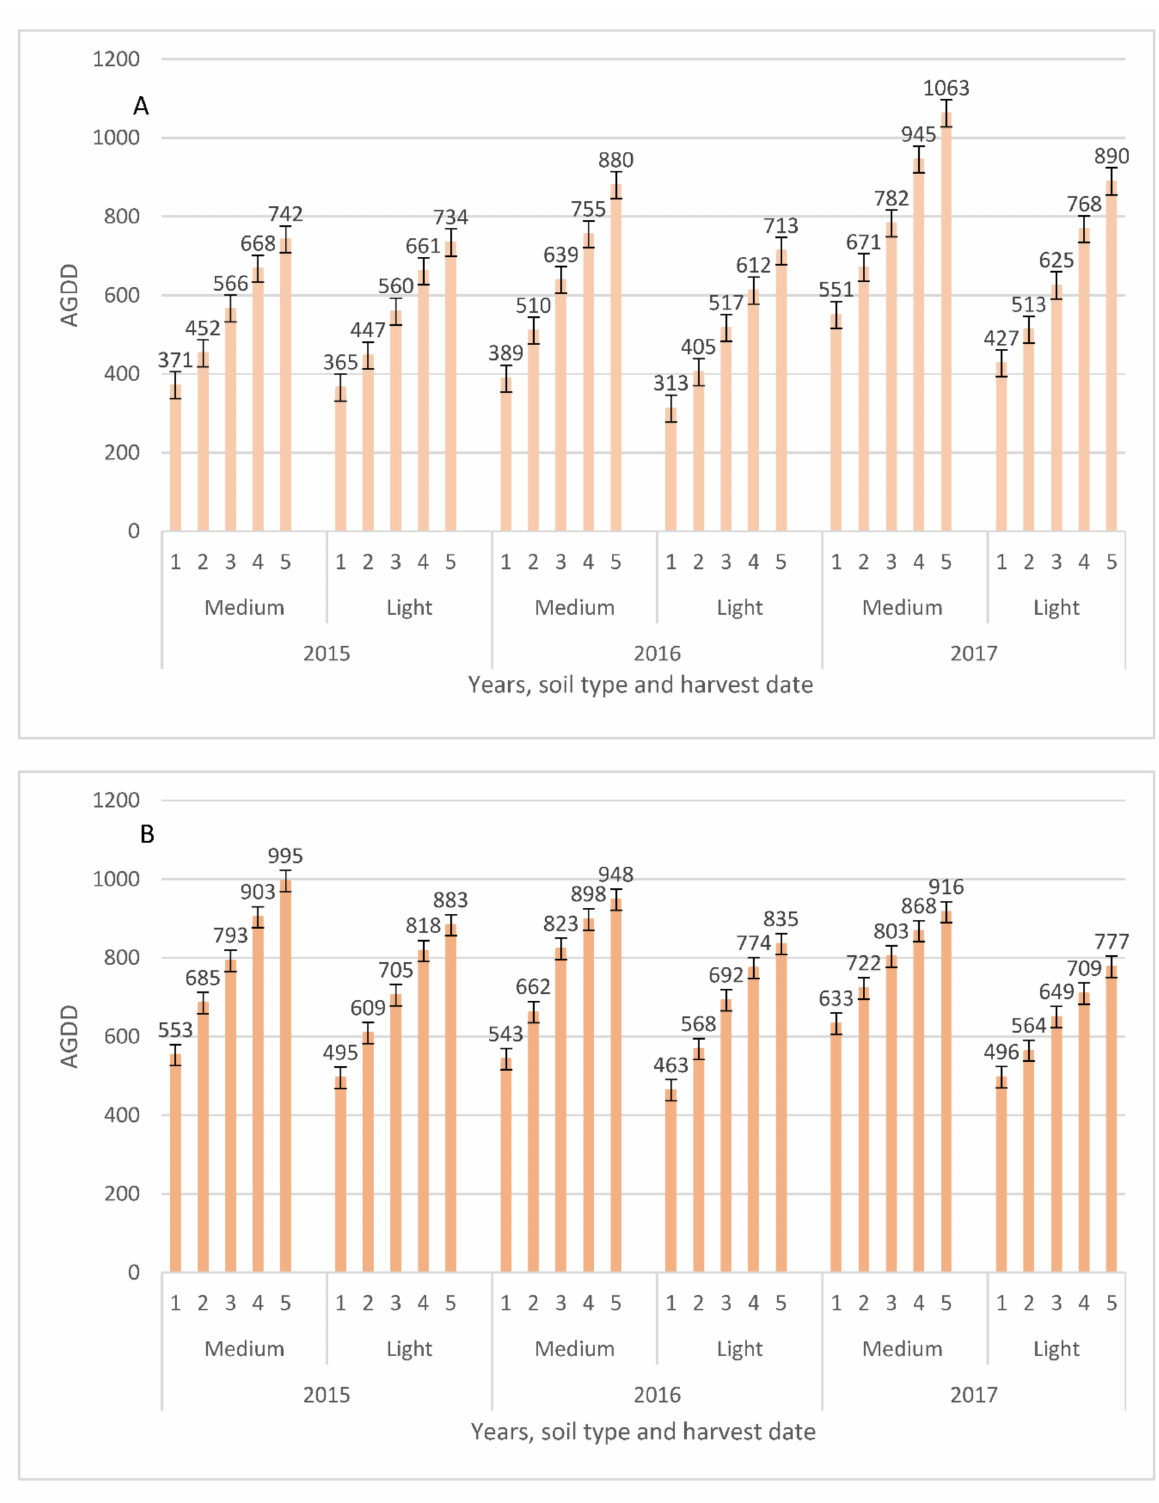
Figure 2. Differences of Accumulated Growing Degree Days during the quinoa vegetation on medium and light soil. ( A ) Spring sowing date, ( B ) Summer sowing